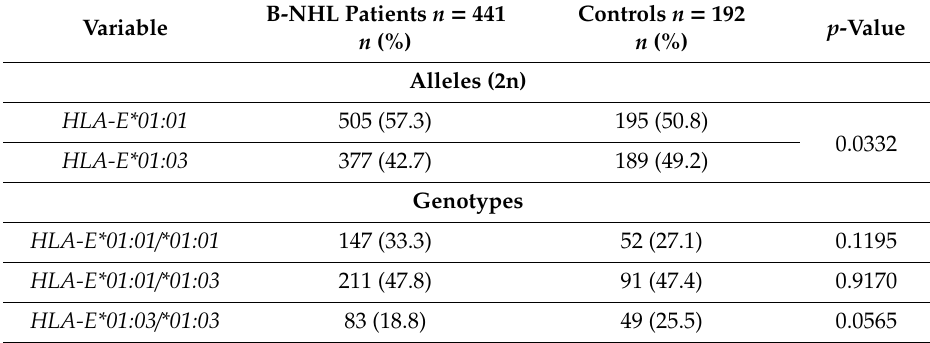
Table 2. Distribution of HLA-E allelic and genotype frequencies of patients and controls. HLA-E*01:01 allele frequencies were increased in B-NHL patients compared to healthy controls. The genotype frequencies did not di ff er between patients and controls.